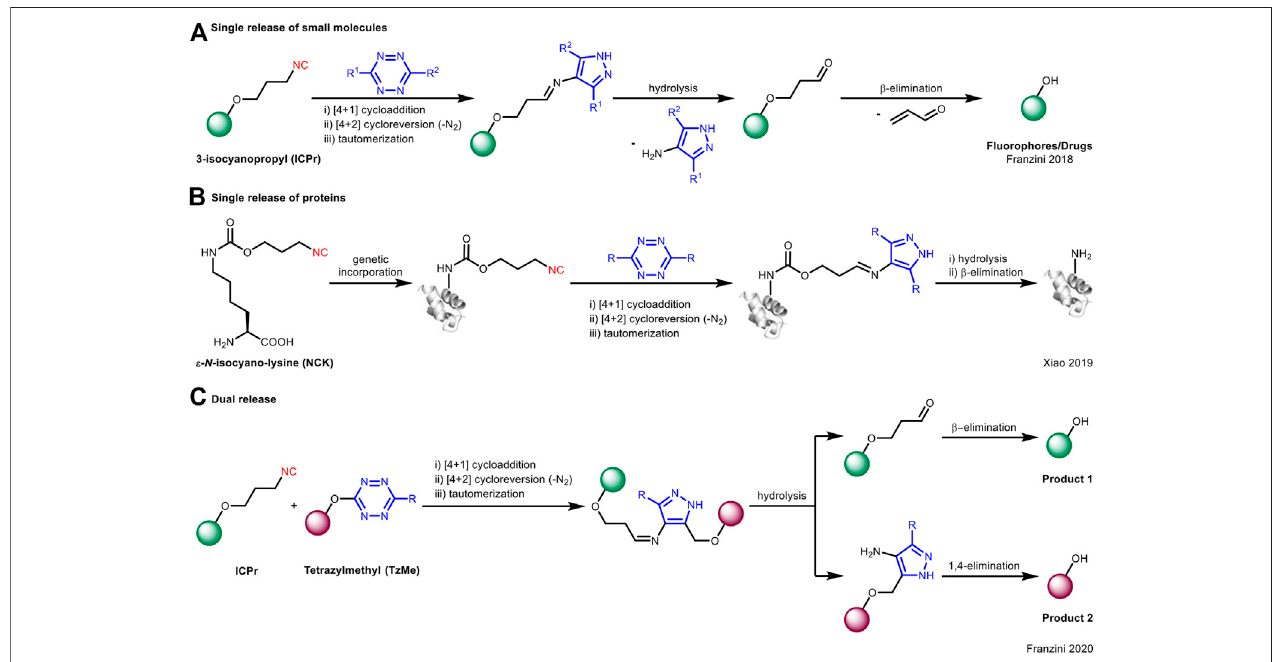
FIGURE 4 | Application of isocyanide-tetrazine chemistry for bioorthogonal cleavage in (A) single release of small molecules, (B) single release of proteins, or (C) dual release of fl uorophores.